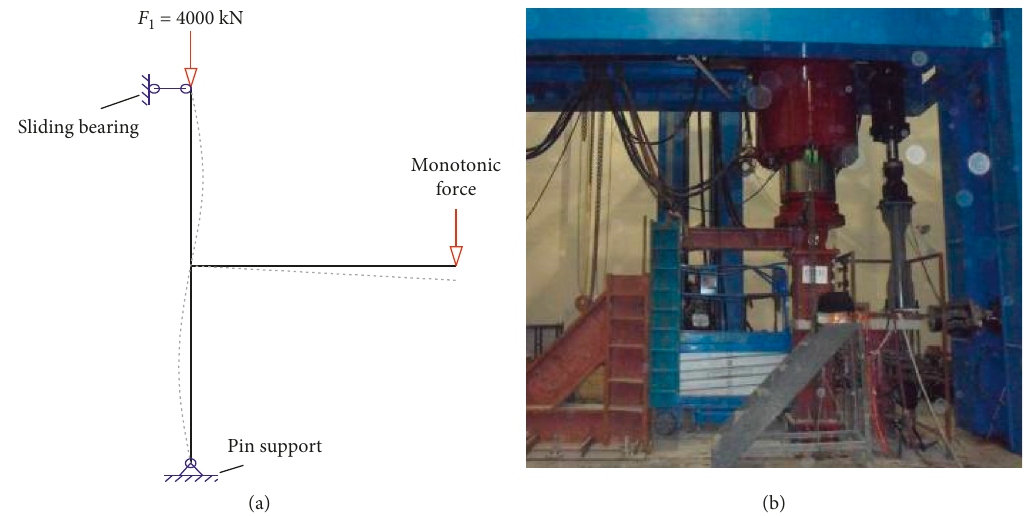
Figure 3: Mechanical model and test setup: (a) mechanical model; (b) photo of the test